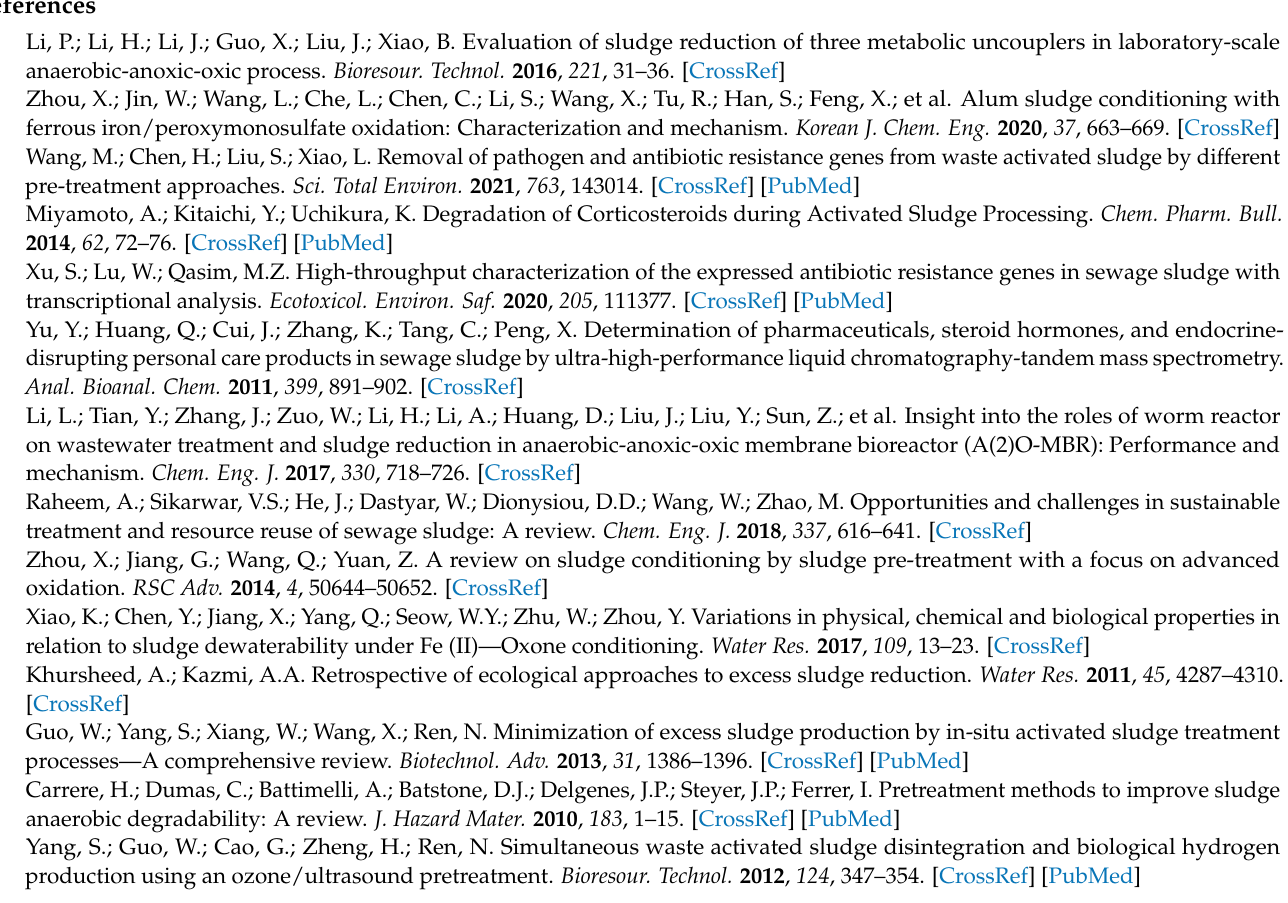
Figure S2: Change of pH of sludge mixture during electrochemical cell lysis, Figure S3: Changes of sludge settling performance during electrochemical cell lysis, Figure S4: Changes of sludge dewatering performance in electrochemical cell lysis